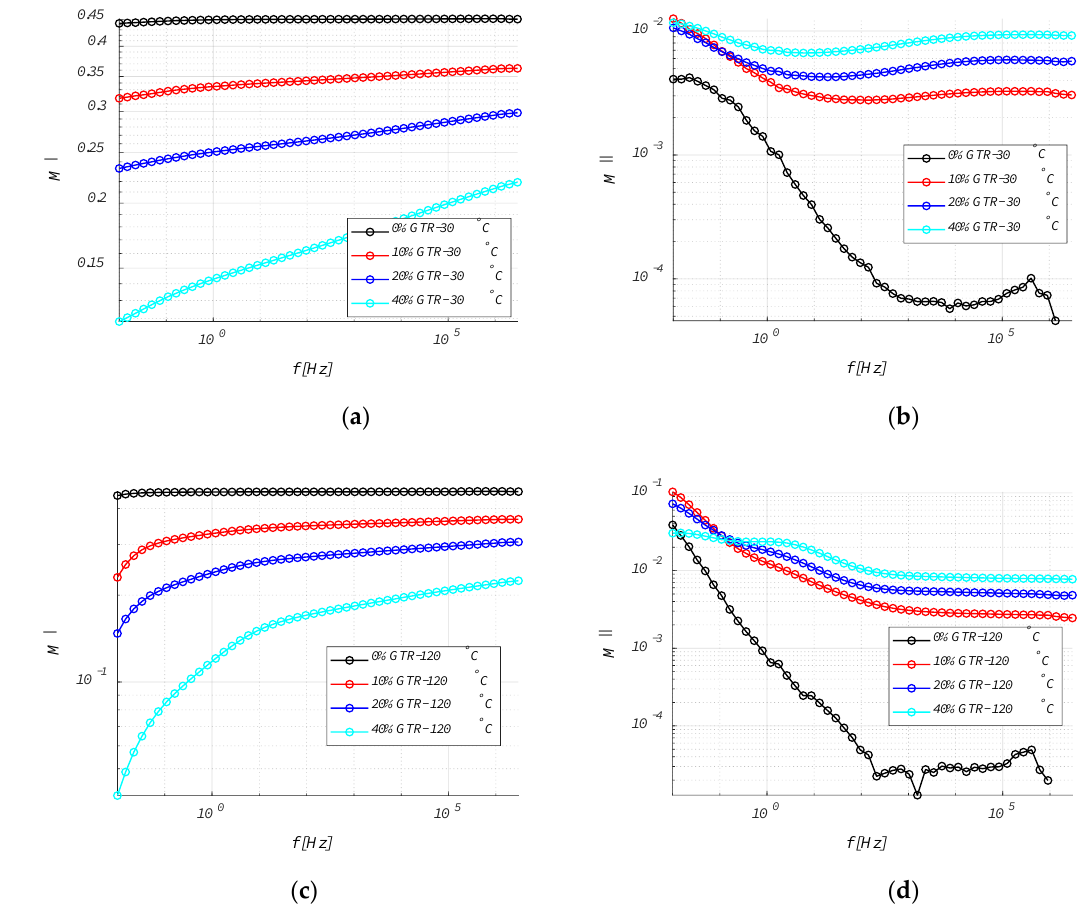
Figure 8. M ′ ( a ) and M ″ ( b ) of HDPE/GTR, at 30 °C and M ′ ( c ) and M ″ ( d ) of HDPE/GTR, at 120 °C, depending Figure 8. M (cid:48) ( a ) and M (cid:48)(cid:48) ( b ) of HDPE / GTR, at 30 ◦ C and M (cid:48) ( c ) and M (cid:48)(cid:48) ( d ) of HDPE / GTR, at 120 ◦ C, depending on on frequency.